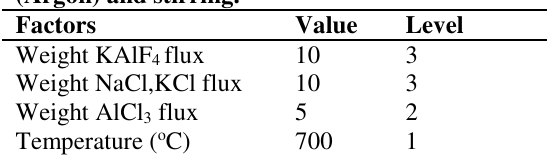
Best optimal levels values of controlled factors for the Aluminum melting with using fluxes , inert gas (Argon) and stirring.